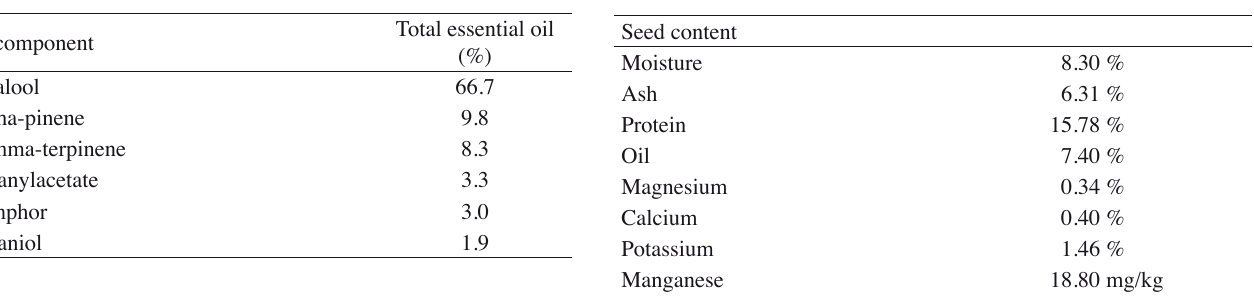
Table 2 - Essential oil component and percentage in seed of C. sativum Table 3 - Main components and mineral contents in seed of C.